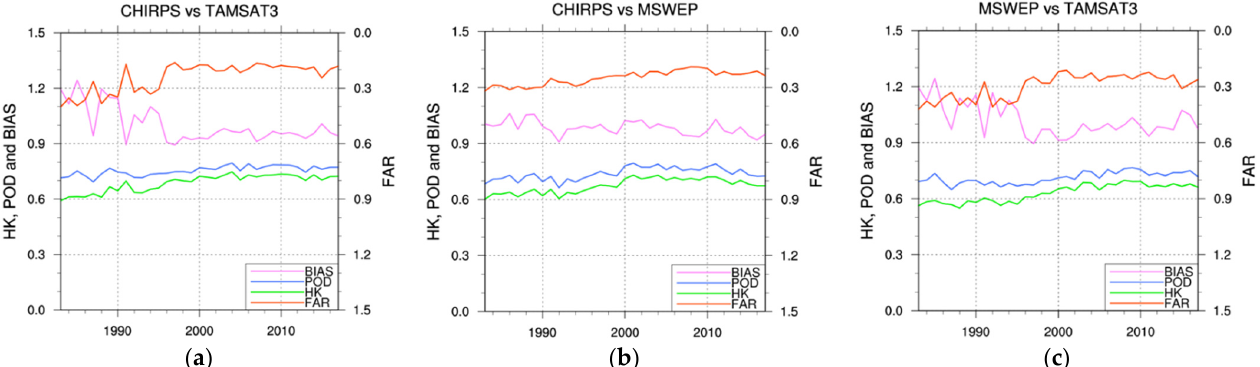
Figure 17. Same as in Figure 14 but for SA: TAMSAT3 with respect to CHIRPS ( a ), MSWEP with respect to CHIRPS ( b ) and TAMSAT3 with respect to MSWEP ( c ).